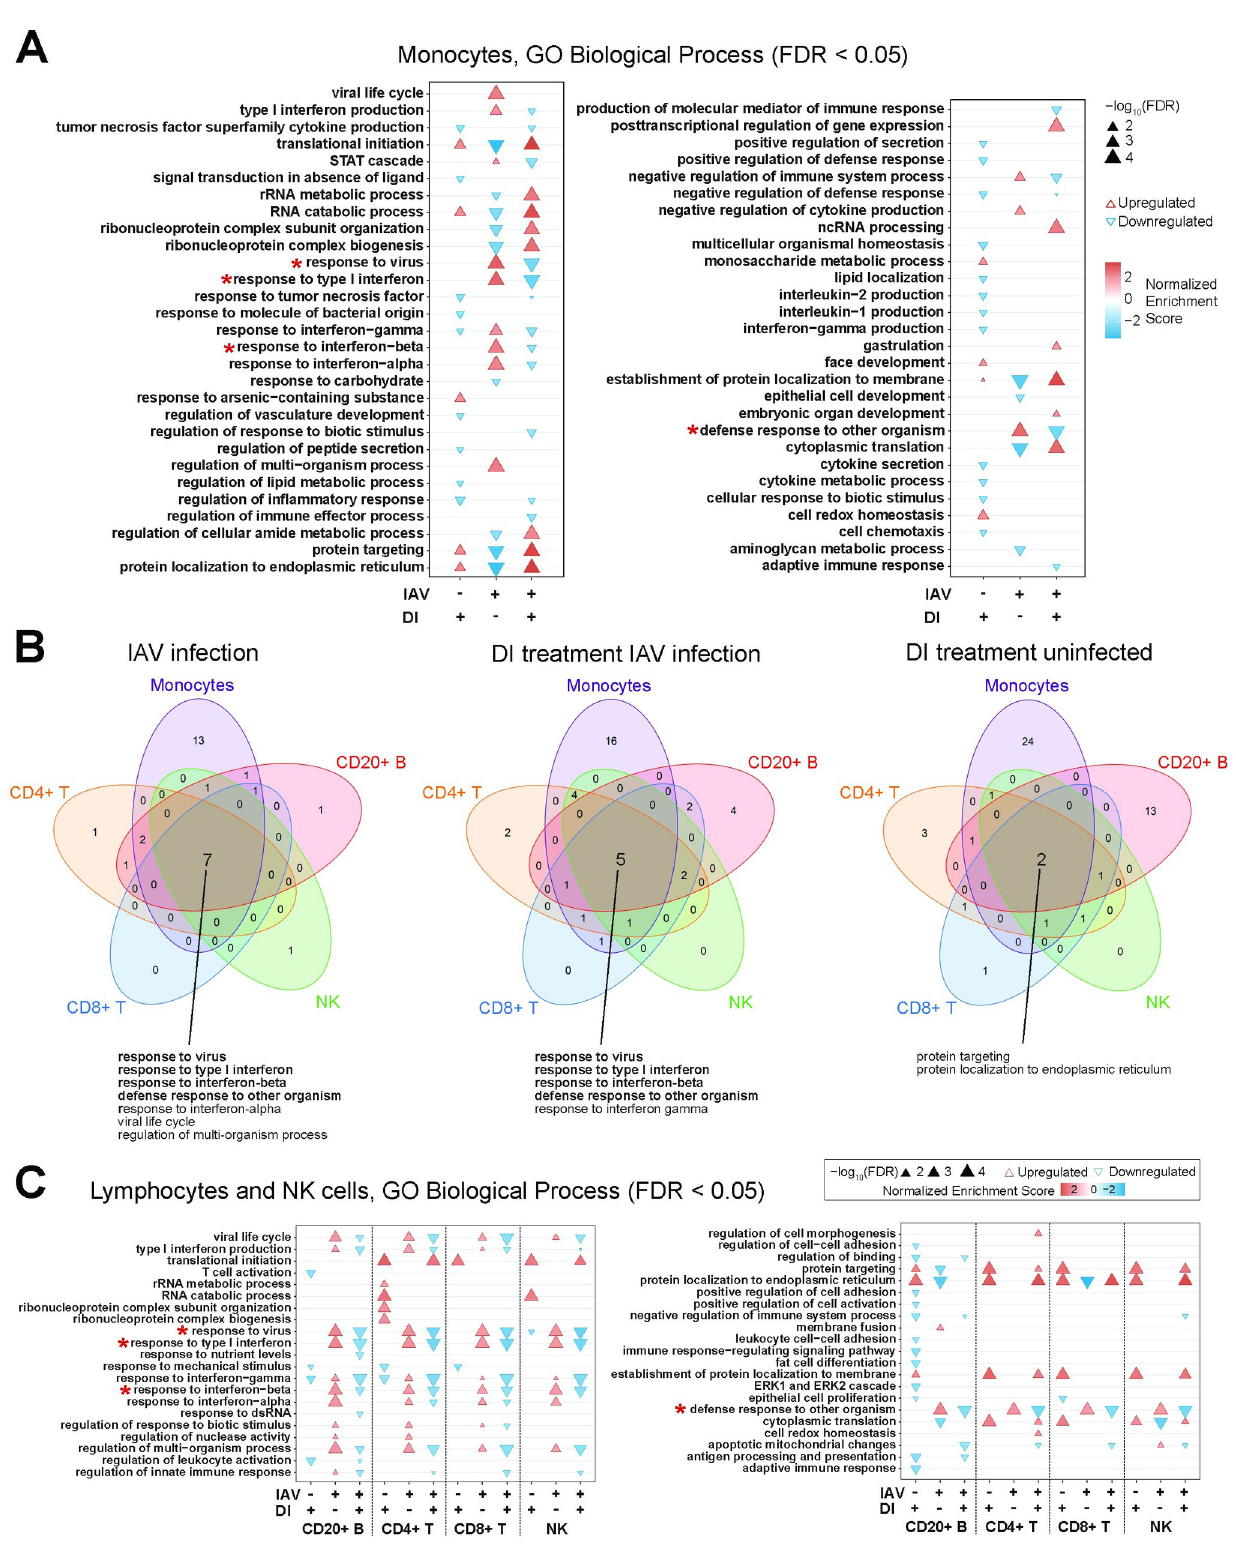
Fig 10. GO enrichment analysis at the single cell level of DI effects on uninfected and IAV-infected PBMCs. Analysis based on the scRNAseq data shown in Fig 9. Go terms that are enriched/depleted in all cell types by infection and DI treatment are marked with a red asterix in A and C. A.